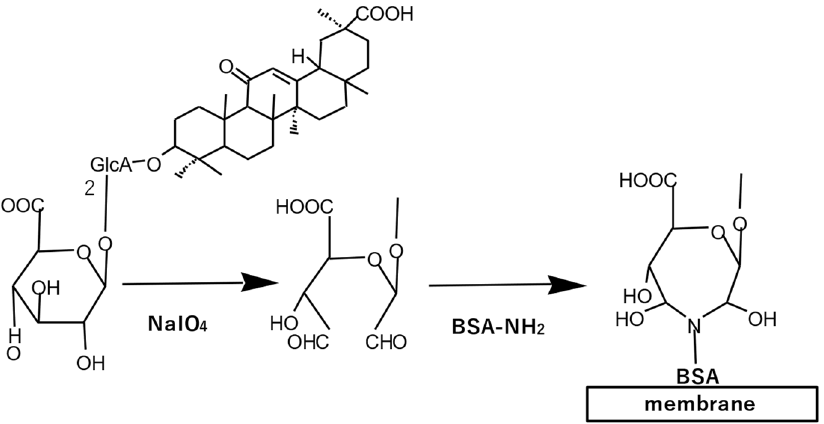
Figure 5. Eastern blotting scheme for glycyrrhizin. Glycyrrhizin blotted on a membrane after thin-layer chromatography was cleaved oxidatively to produce an intermediate form, which could be conjugated with bovine serum albumin resulting in its fixation onto the membrane, e.g., a polyvinylidene difluoride or a polyethersulfone membrane. Staining was performed using an anti-glycyrrhizin monoclonal antibody.